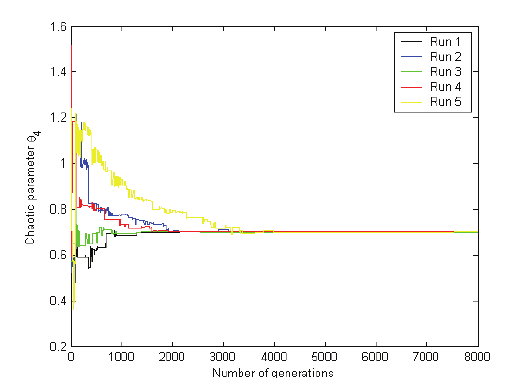
Fig. 7. Convergences of parameter runs (Run 1~Run